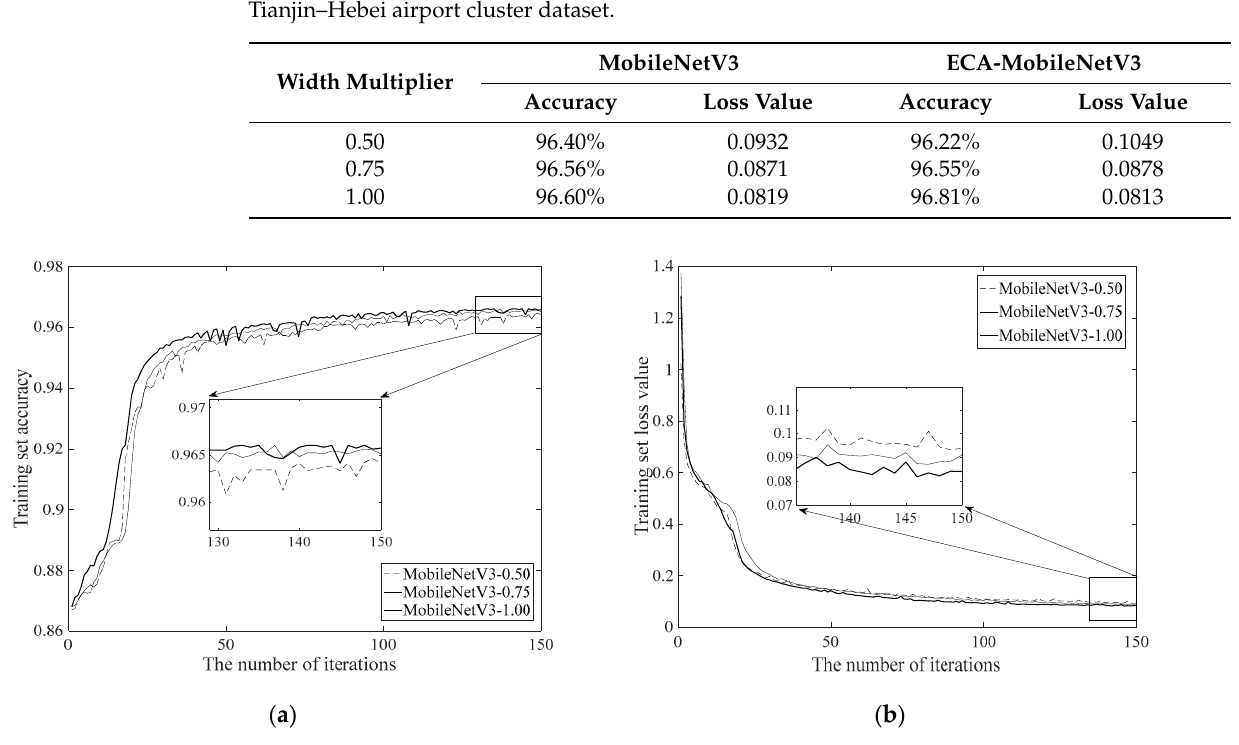
Figure 7. Comparison of loss values and accuracy for different-width multipliers based on the MobileNetV3 algorithm on Beijing–Tianjin–Hebei airport cluster dataset. ( a ) Accuracy comparison of different-width multipliers. ( b ) Loss value comparison of different-width multipliers.